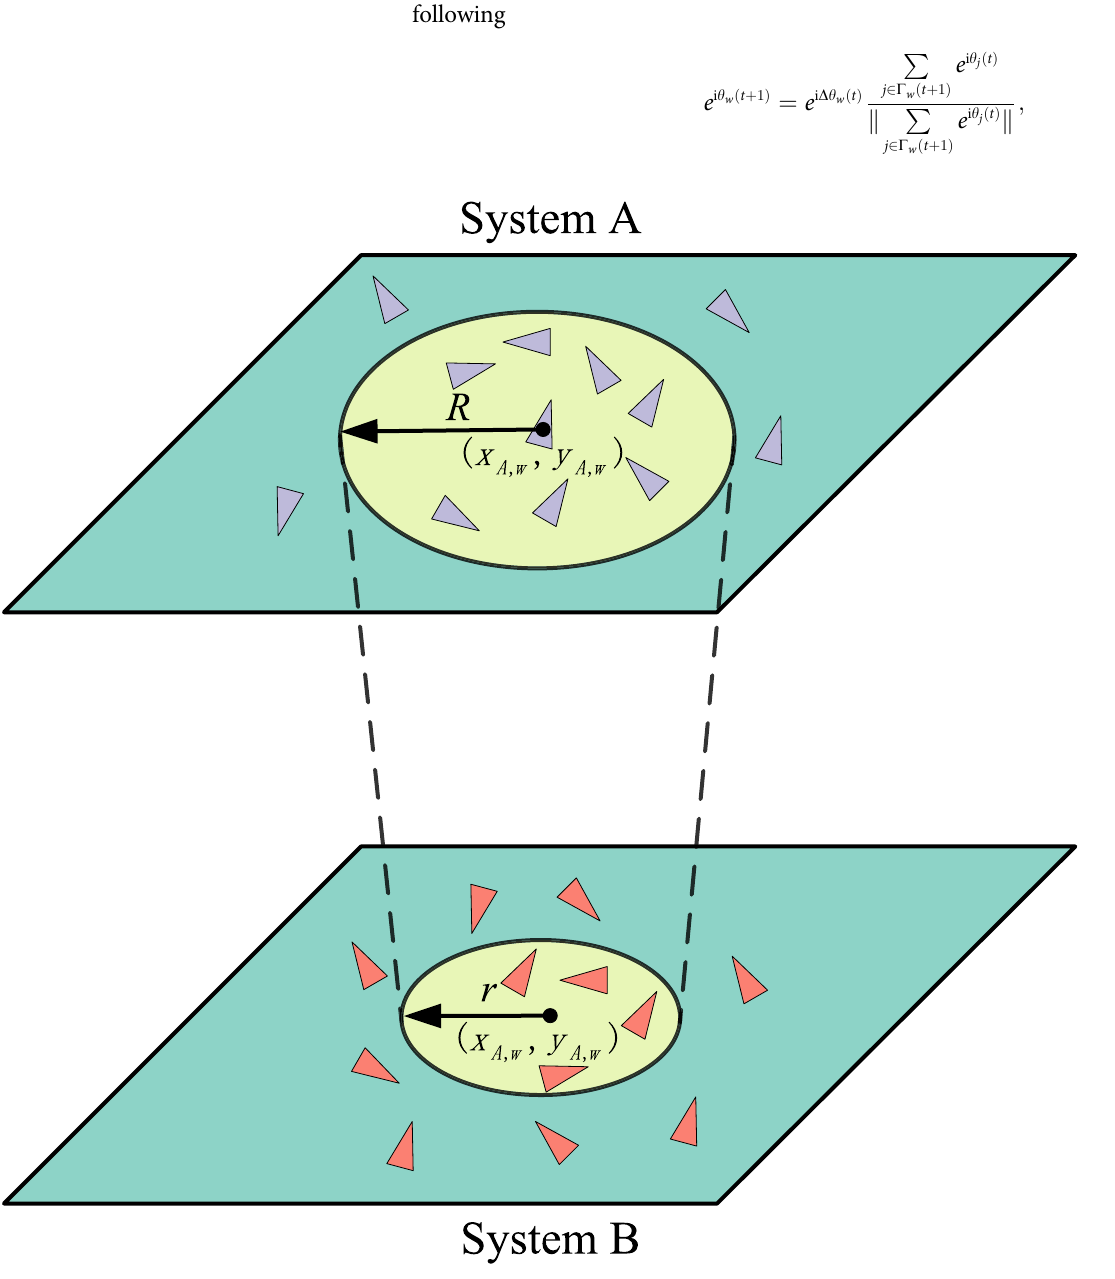
Fig 1. In system A, the position of node w is ( x A , w , y A , w ), and it has 7 neighboring agents within a circle with a radius being R [Eq (3)], whose position projecting on system B is also ( x A , w , y A , w ), and it has 4 neighboring agents in system B [Eq (4)]. Accordingly, we could identify the neighborhoods of all nodes in both